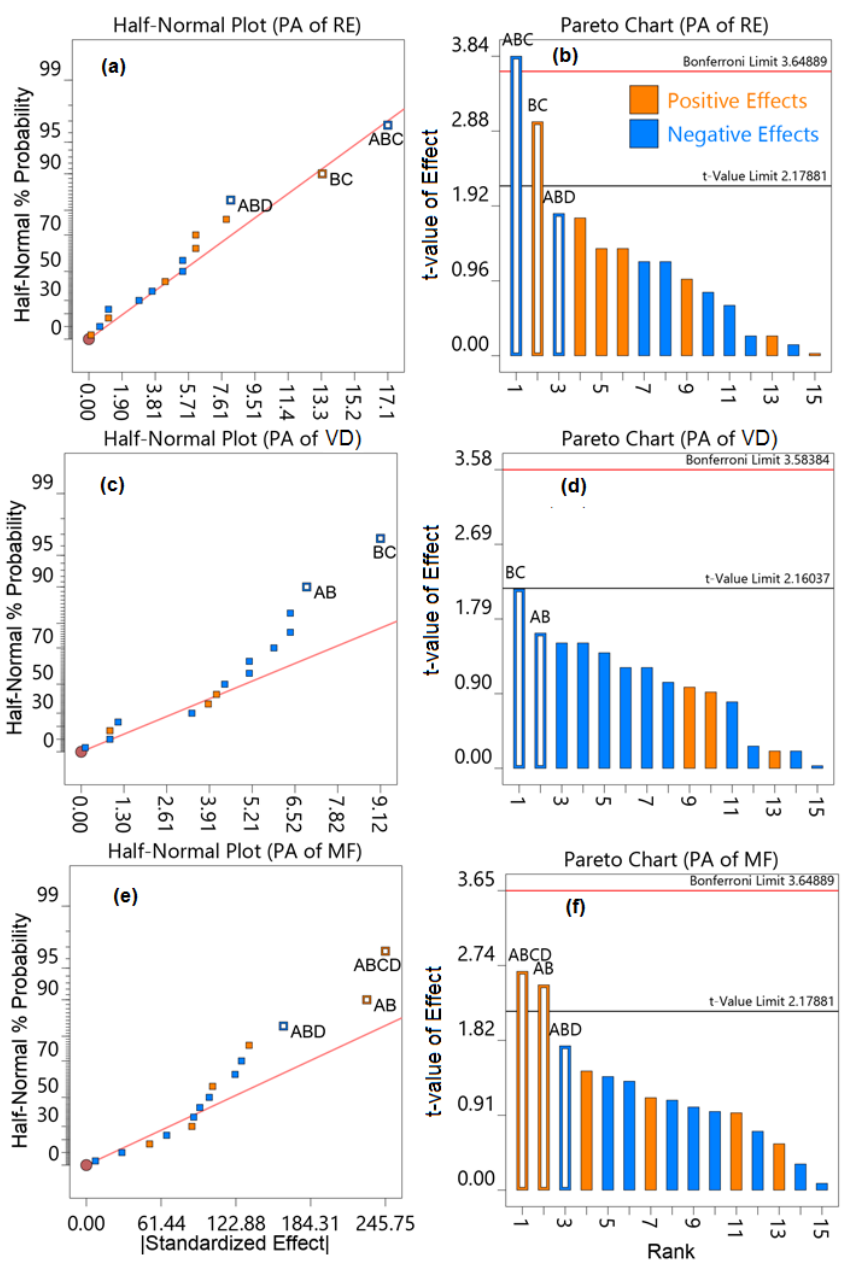
Figure 7. Half-normal probability plots and Pareto charts showing the effect of the concentration of acetonitrile (A), pH of the mobile phase (B), flow rate (C), and wavelength of the detector (D) on the peak area of RE ( a , b ), VD ( c , d ), and MF ( e , f ). PA: peak area.